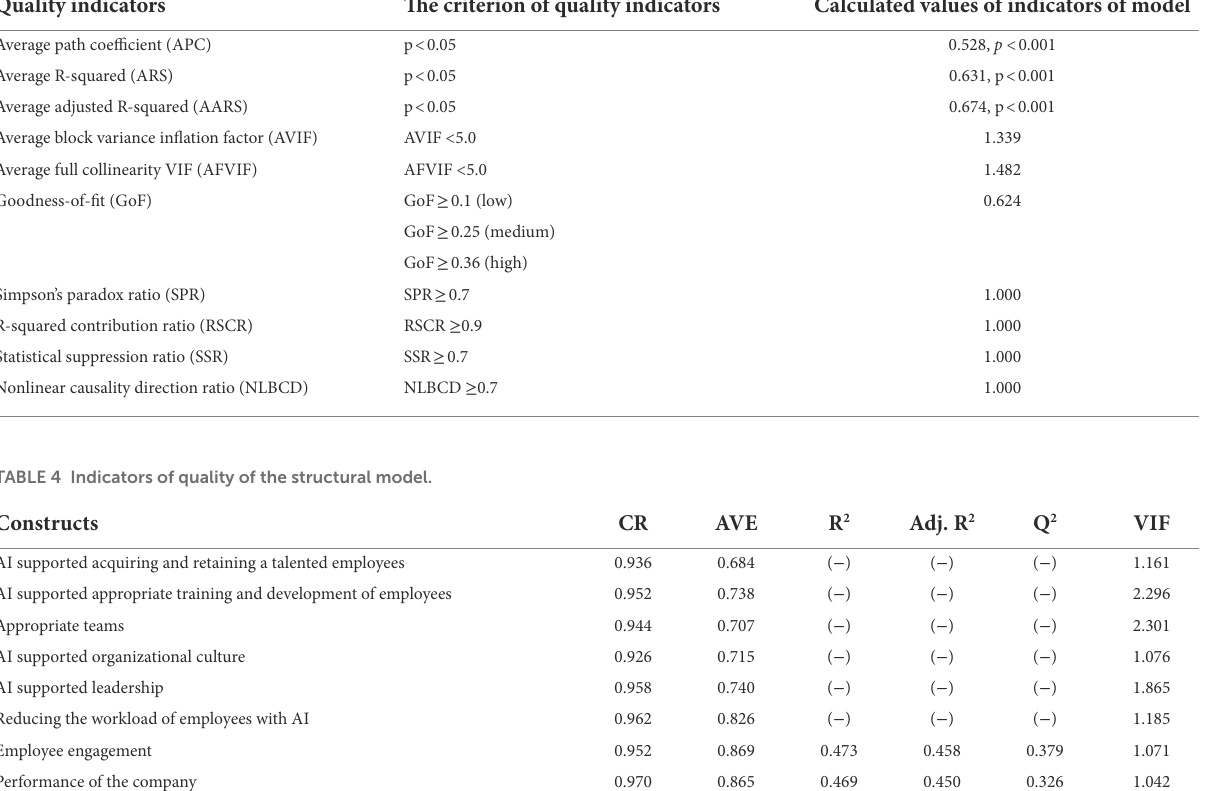
TABLE 3 Model fit and quality indicators.